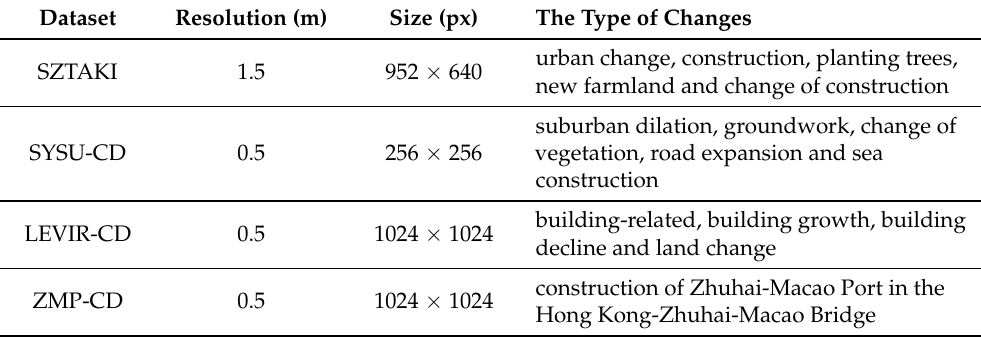
Table 1. The description of the